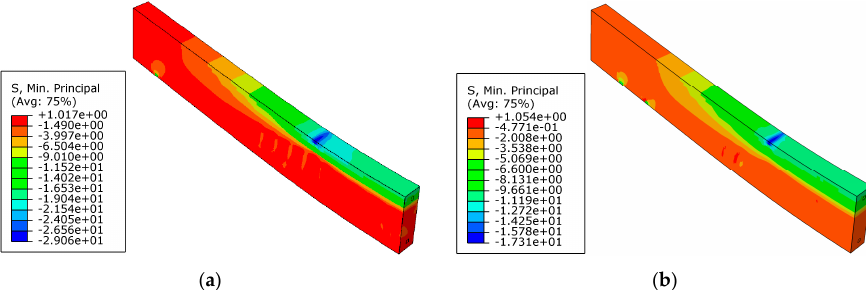
Figure 14. Minimum principal stress of concrete for the reference beam and strengthened beam under a load of 50 kN: ( a ) reference beam; ( b ) CG11 strengthened beam with prestress level 33% (unit: MPa).